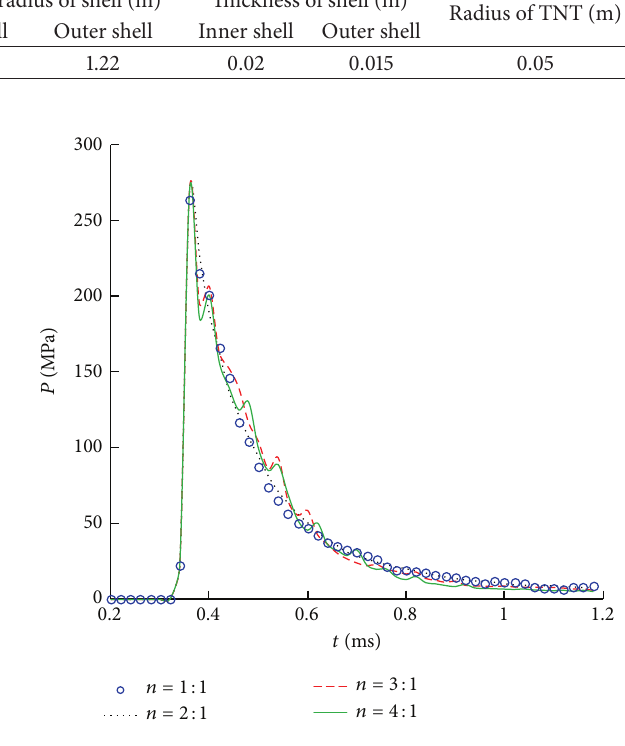
Figure 5: The pressure-time curves of test point A in the cases with different initial particle spacing; 𝑛 is the ratio of initial particle spacing between water and